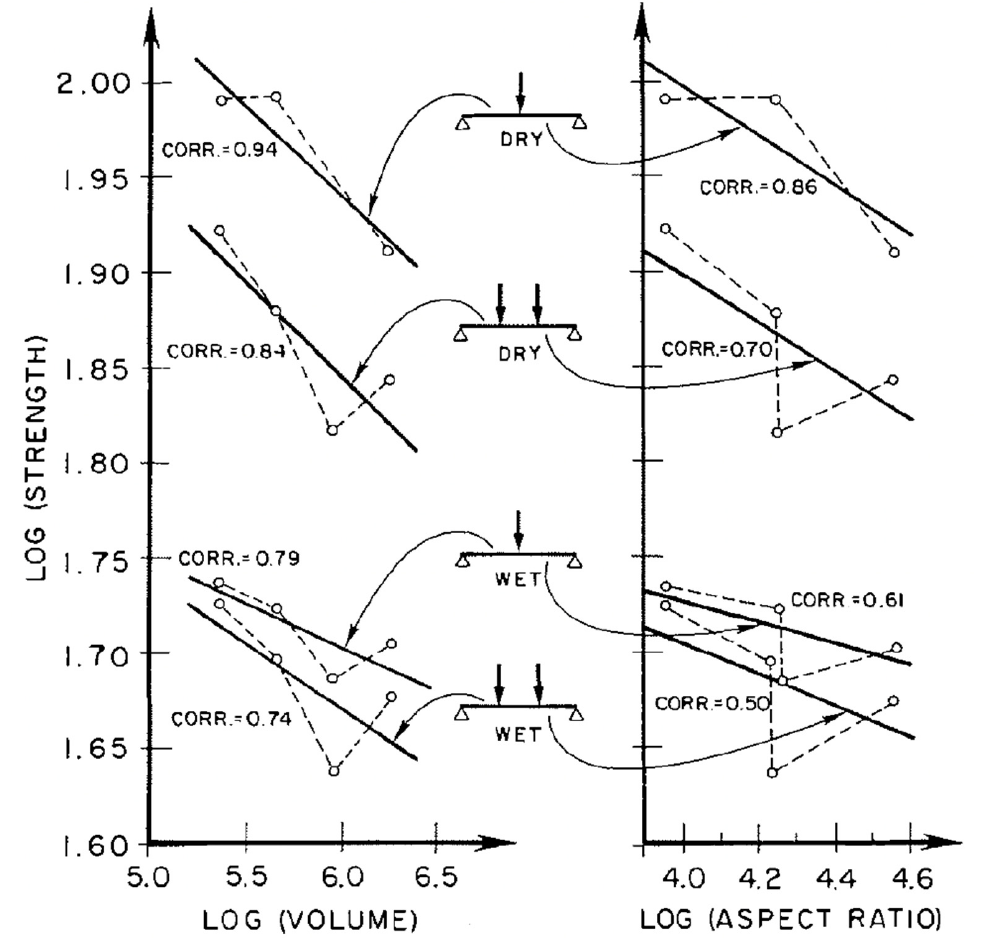
Figure 44. Plots of log(strength) vs. log(volume) and log(aspect ratio) for defect-free Douglas Fir. From [103].